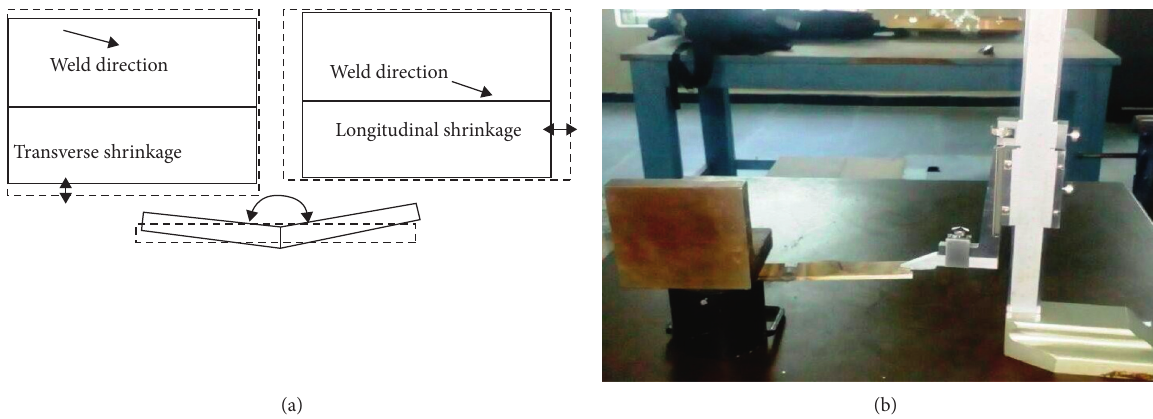
Figure 2: (a) Different types of weld distortions and shrinkages. (b) Measurement of weld distortion using Vernier height